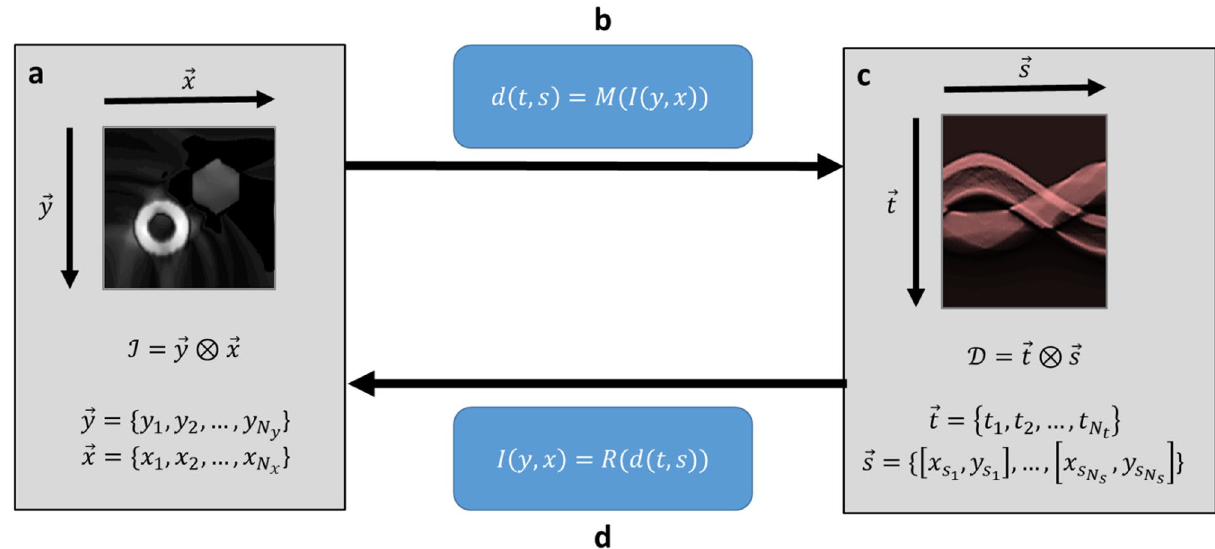
Figure 2. Image-data mappings. An image ( a ) consisting of some explicit values, is organized according to the coordinate system I . ( b ) Through the transformation effected by the forward model operator M , one determines ( c ) the photoacoustic data in coordinate system D . In practice, one acquires the data and ( d ) seeks to reconstruct the corresponding image through the action of some reconstruction operator R . Iterative schemes are often favored for the reconstruction process, and so R is implicitly dependent on the operator M . Figure created using a combination of MATLAB and Microsoft